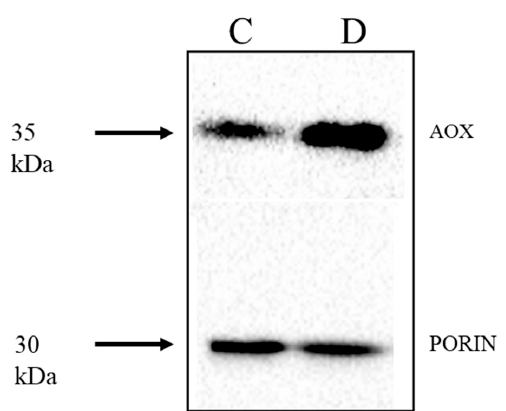
Figure 10. Detection of AOX protein in barley exposed to moderate drought stress. Soil grown 12 days old barley seedlings ( Hordeum vulgare , cv. Golden Promise) were exposed to drought stress by withholding water for 14 days under greenhouse conditions. AOX protein was detected in total protein extracts of shoot tissue in plants grown in well-watered controls (C) and drought, withhold conditions (D) resolved under reducing conditions. The relative water contents for the plant were 83% and 69% in control and drought conditions, respectively.